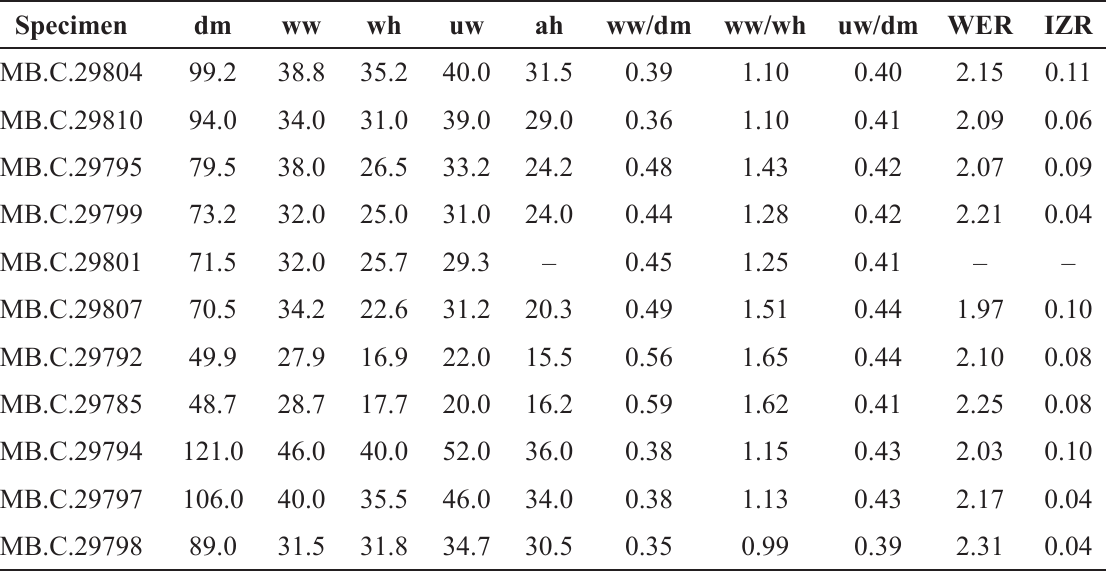
Table 12. Conch dimensions (partly estimated) and ratios of selected specimens of Paratirolites vediensis Shevyrev, 1965 from Baghuk